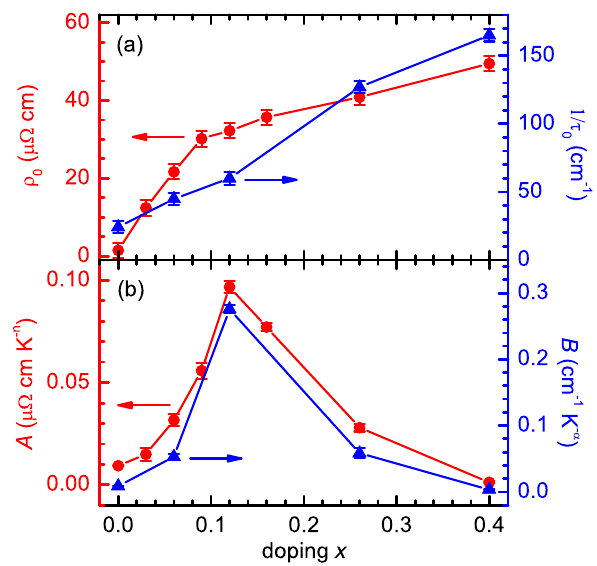
FIG. 8. (a) Doping dependence of ρ 0 (solid circles) and 1 = τ 0 (solid triangles). (b) Coefficients A for transport (solid circles) and B for optics (solid triangles) determined from the single power-law fit as a function of Co